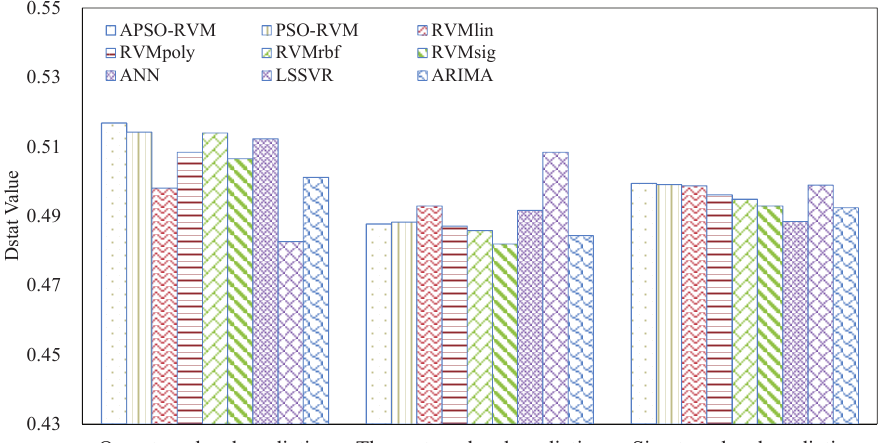
Figure 4. Root mean square error (RMSE) by different single methods.